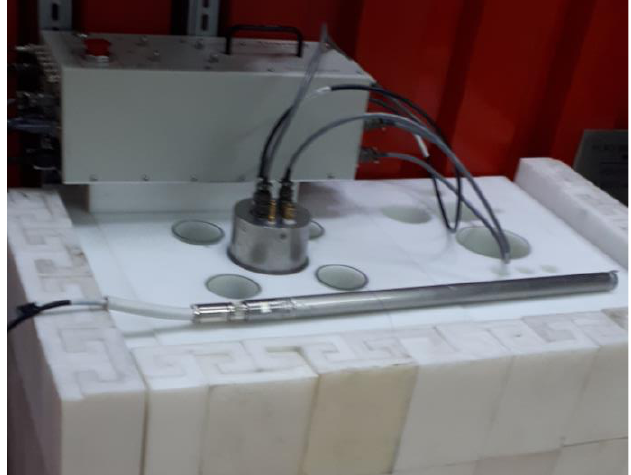
Fig. 2. Neutron generator in the central channel of the PE block